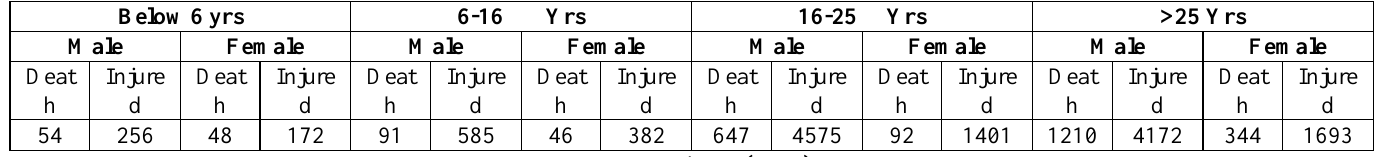
Table 28: Death rate in road accident estimated per 10000 motorized vehicles (excluding 2 and 3 wheelers), 2019. Age group of Population Children under 5 Yrs. Children from 5-15 Yrs.